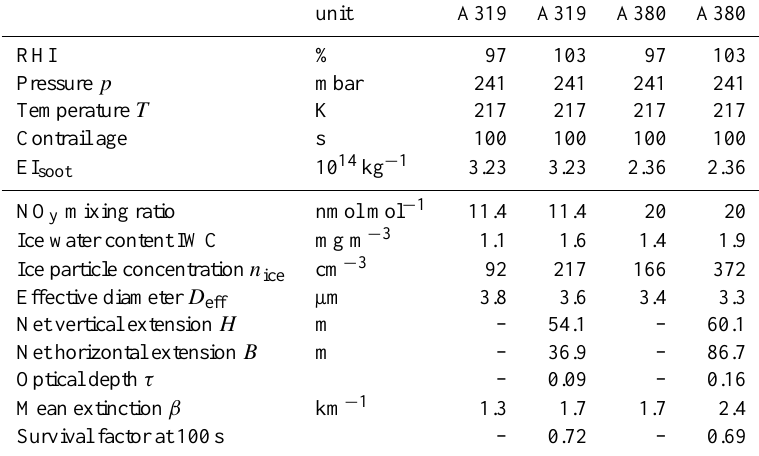
Table 4. Parameters used in the EULAG-LCM model (top) and model results (bottom). Extinction, optical depth τ , effective diameter D eff , particle number density n ice and the ice crystal survival factor are calculated with the EULAG-LCM model simulating the observation process. Results for assumed initial RHI of 97% and 103% are shown. NO y values are calculated under the assumption of NO y being a (Table 1) and assuming that all NO y is trapped within the passive, non-reactive tracer. Initial NO y values are calculated by using EI NO x vortex at 20s contrail